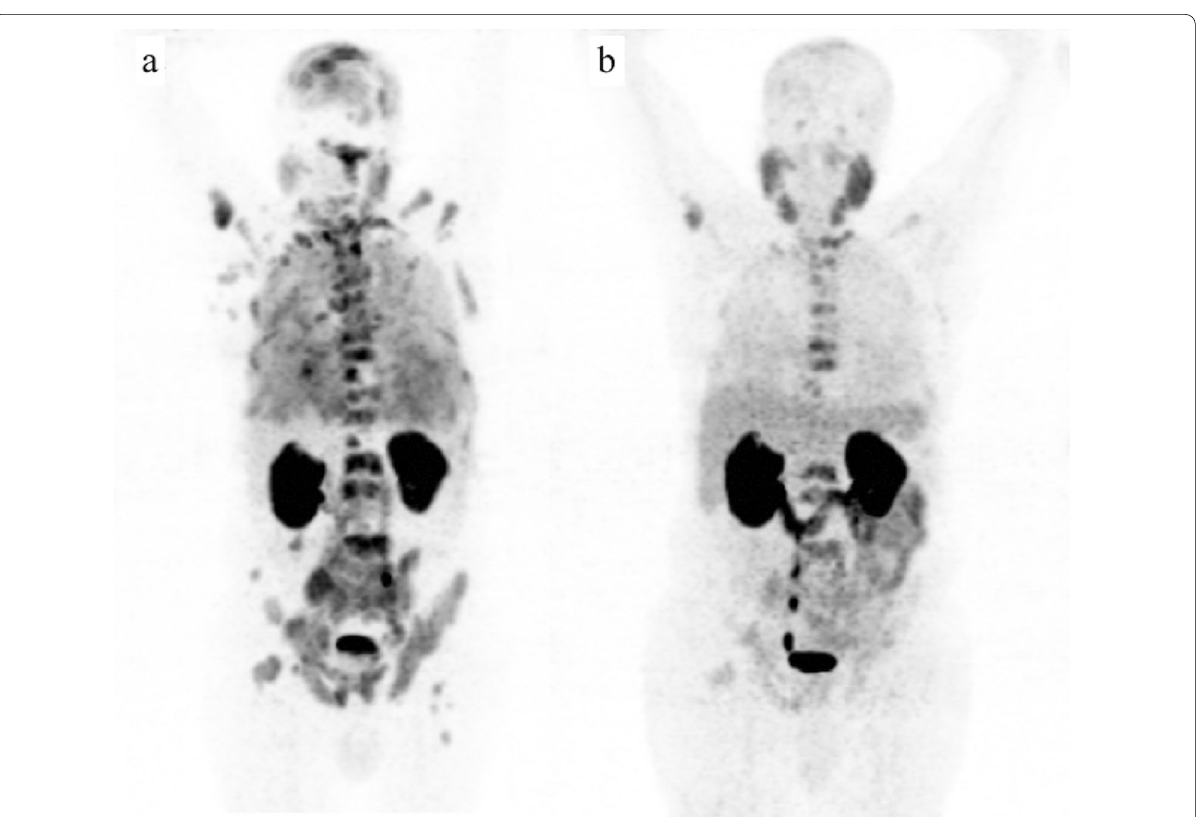
Fig. 1 Serum PSA value of a 78 years old patient with prostate adenocarcinoma falled to 0.33 ng/ml from 5476 ng/ml ( a) after leuprolide docetaxel therapy regimen. A significant regression in the lesions of prostate gland, bilateral lungs, lymph nodes and bones is seen + after on [ 68 Ga]Ga-PSMA-11 PET/CT images following therapy ( b